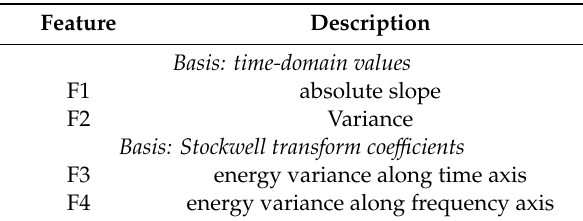
Table 3. Features for z-score based disturbance detection.